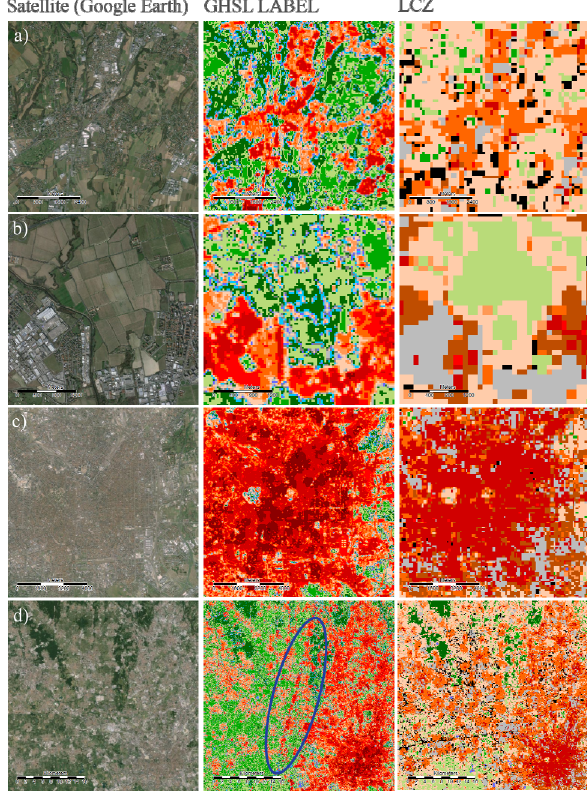
Figure 5. Selected areas in Milan, colours as in Table